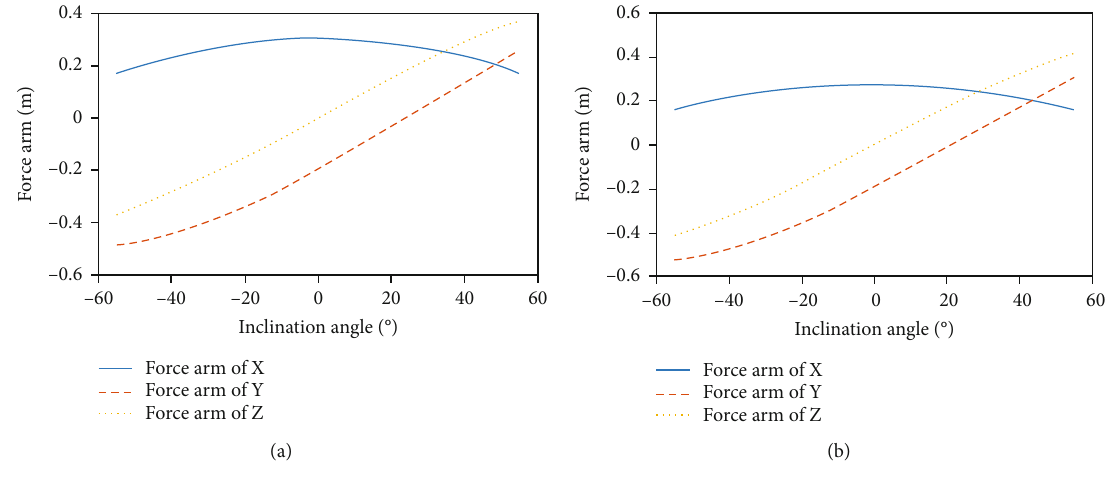
Figure 11: (a) Initial force arm. (b) Final force